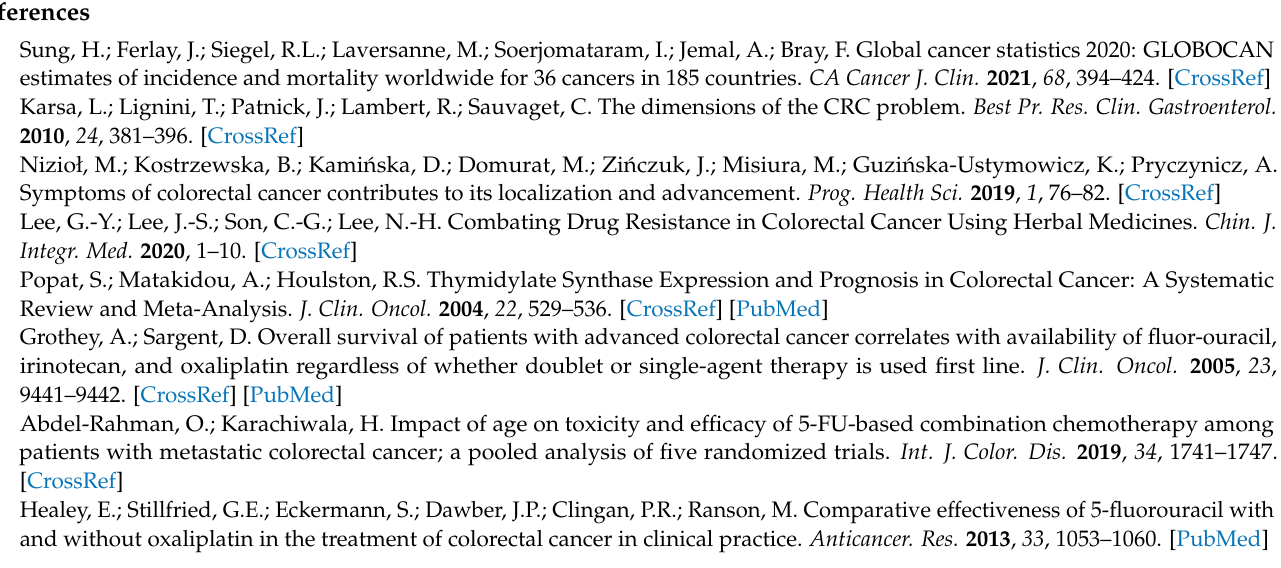
supernatant and lysate of HCT116/R